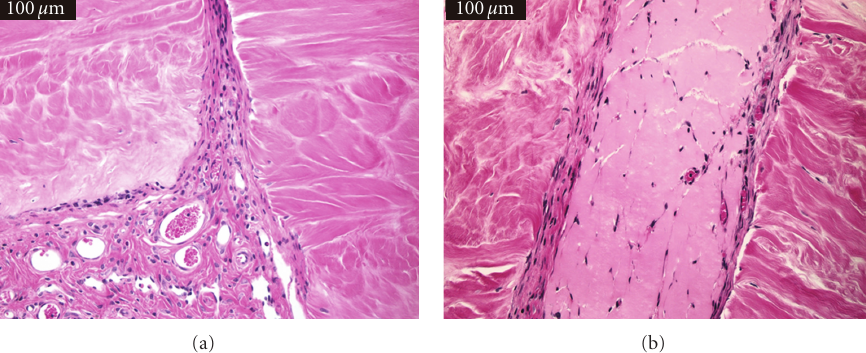
Figure 2: (a) shows thin repair tissue and vasculature ingrowth in Group 1 meniscal section. (b) shows a grouping of small vessels within a large amount of fibrinous tissue between two meniscal sections in Group 0 construct.